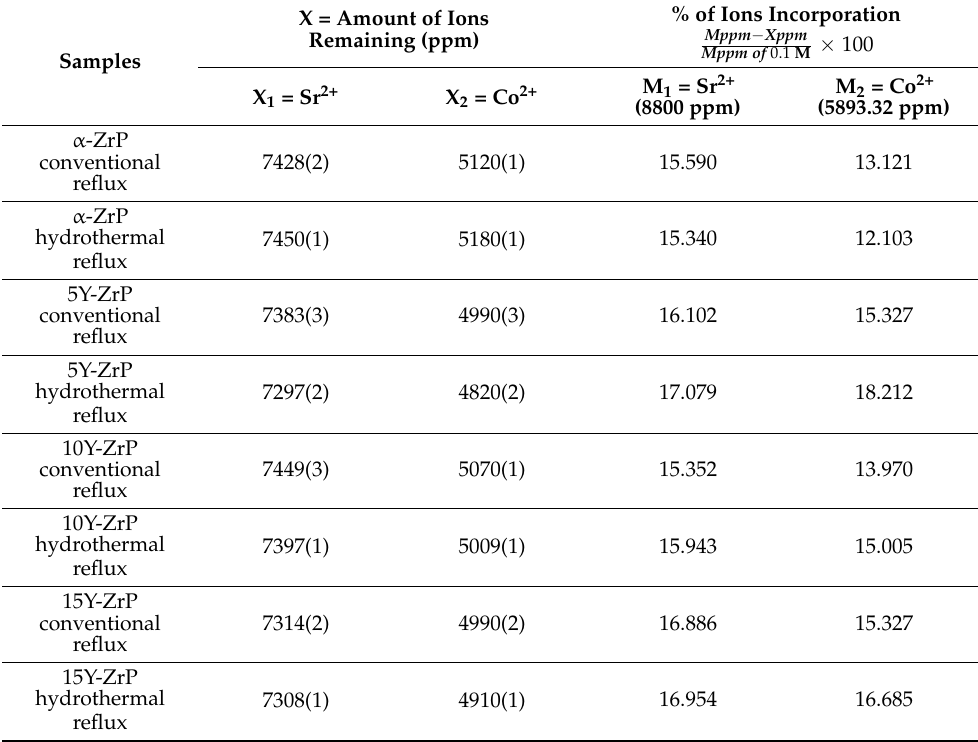
Table 10. Summary of the ICP-MS results for strontium–cobalt exchange.